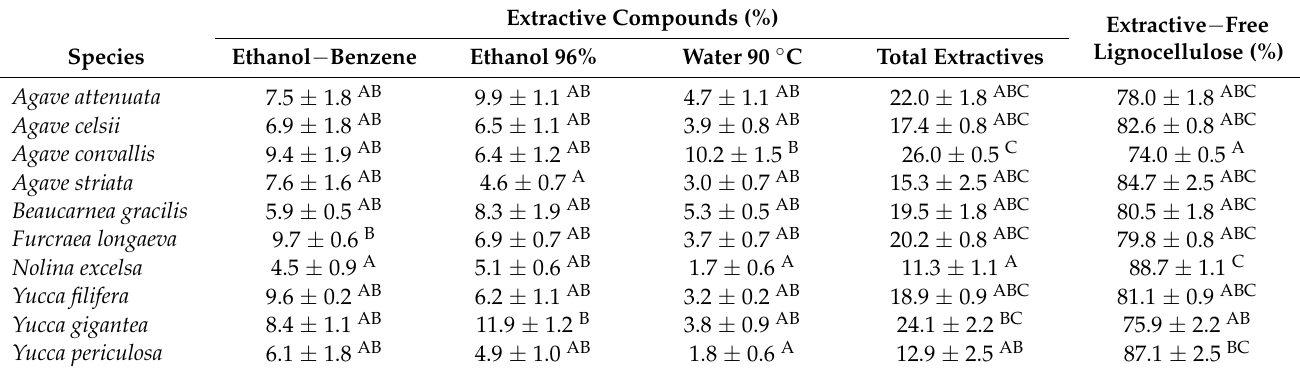
Table 3. Extractives percentage from the 10 Asparagaceae species.